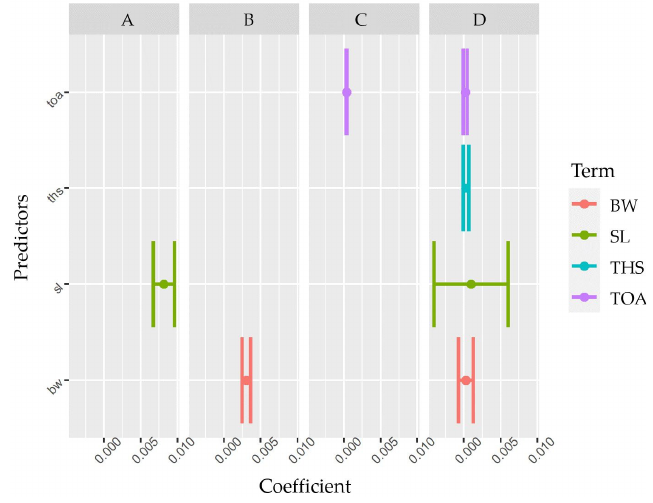
Figure 6. Predicted models for intermuscular bones length in tambaqui. Estimation of effects on intermuscular bones length in tambaqui ( Colossoma macropomum ). ( A )—standard length effect model. ( B )—body weight effect model. ( C )—trunk over axis effect model. ( D )—multiple effect model. The regression analysis of IBs (y) and growth parameters (x) showed that they fit an optimal model considering standard length (R 2 = 0.50, p < 0.0001), which indicated a positive correlation between IB length from X‑ray and standard length (Figure 7A). The same pattern was found between IB length and body weight (R 2 = 0.46, p < 0.0001), TOA (R 2 = 0.53, p < 0.0001), THS (R 2 = 0.48, p < 0.0001) and total area (R 2 = 0.54, p < 0.0001; Figure 7B–E).